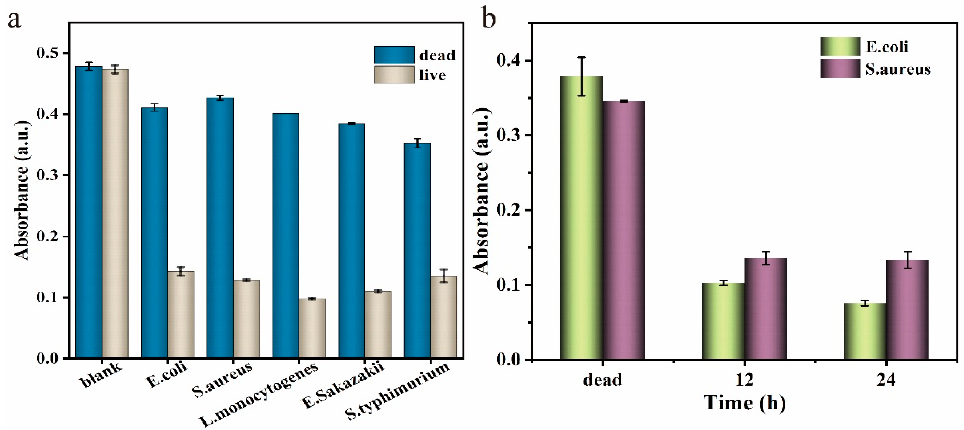
Figure 4. ( a ) The absorbance value of different strains at 652 nm to observe the bacterial viability . ( b ) Detection of bacterial activity ( E.coli and S. aureus ) after different incubation time. ( b ) Detection of bacterial activity ( E. coli and S. aureus ) after different incubation